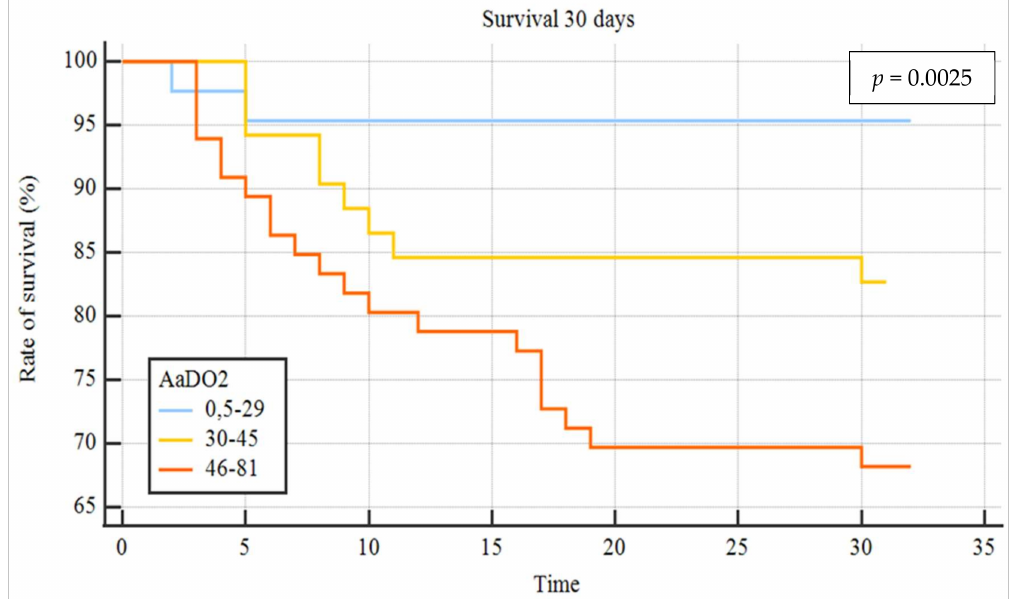
Figure 5. AaDO 2 Kaplan–Meier curves in whole cohort. AaDO 2 groups of values: blue line (0.5–29), yellow line (30–45) and orange line (46–81). Table 2. Patients